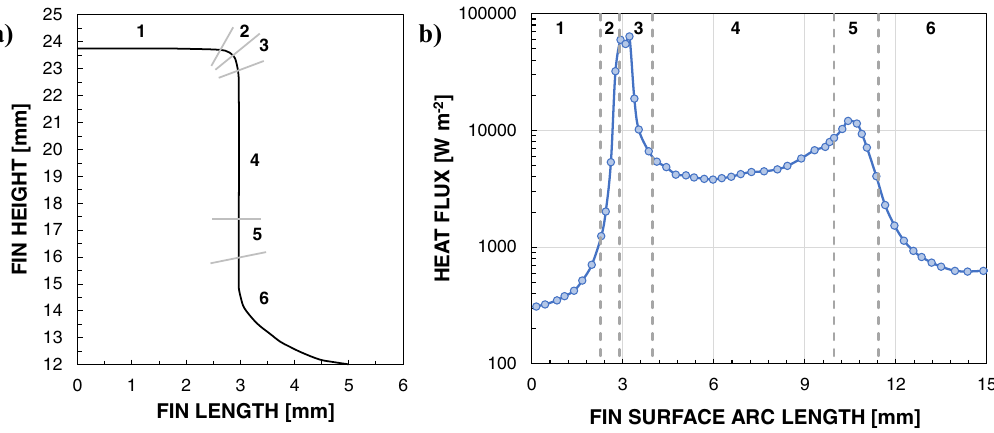
Fig. 9 Condensation heat transfer on a fi n surface under microgravity. Heat fl ux distribution ( b ) under microgravity for each selected area of the fi n ( a ) (Glushchuk et al. 70